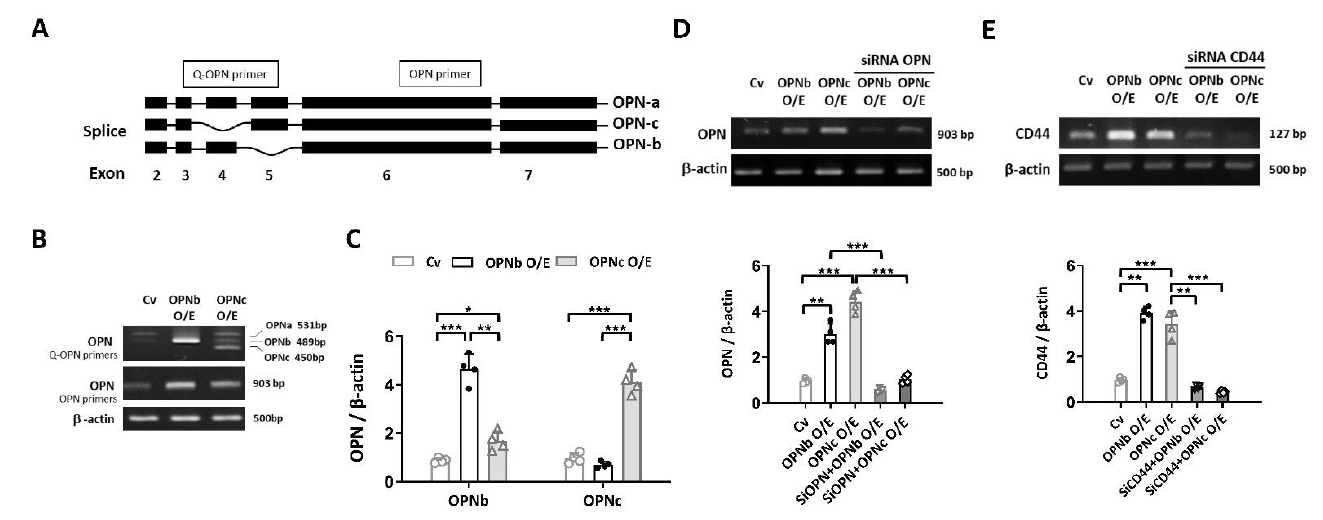
Figure 4. The efficiency of OPN isoform transfection and CD44 knockdown in OPN-overexpressing HEC1A cells was identified by real-time PCR. ( A ) Schematic illustration of OPN isoforms OPNa, OPNb, and OPNc. ( B ) OPN splice variants, OPNb and OPNc, were transfected into endometriotic cells. The vector only was used as a control (Cv). ( C ) The expression of OPN splice variants in the OPNb- or OPNc-transfected cell lines was identified by quantitative real-time PCR. ( D ) OPN silenc- ing with OPN-siRNA in OPNb/OPNc-overexpressing endometriotic cells. ( E ) CD44 knockdown efficiency was identified by real-time PCR. Cv: control vector; O/E: overexpression. Plots represent the mean ± SEM, n = 4. ( * ) indicates a significant difference with p < 0.05. ( ** ) indicates a significant difference with p < 0.01. ( *** ) indicates a significant difference with p < 0.001. Phalloidin with tetramethylrhodamine (TRITC) and DAPI were used to stain the